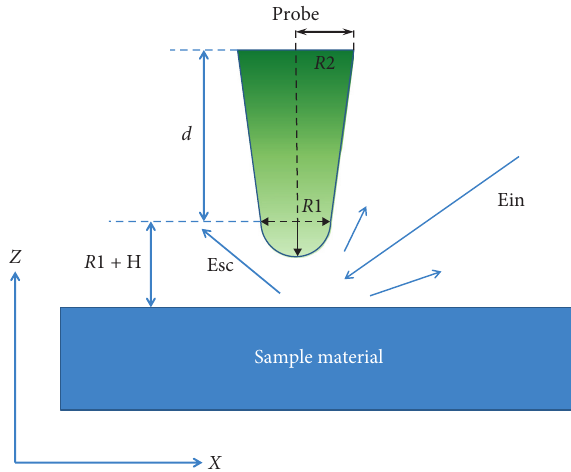
Figure 1: Incident and scattering fields of the near-field probe on the surface of the plane sample after incident by plane